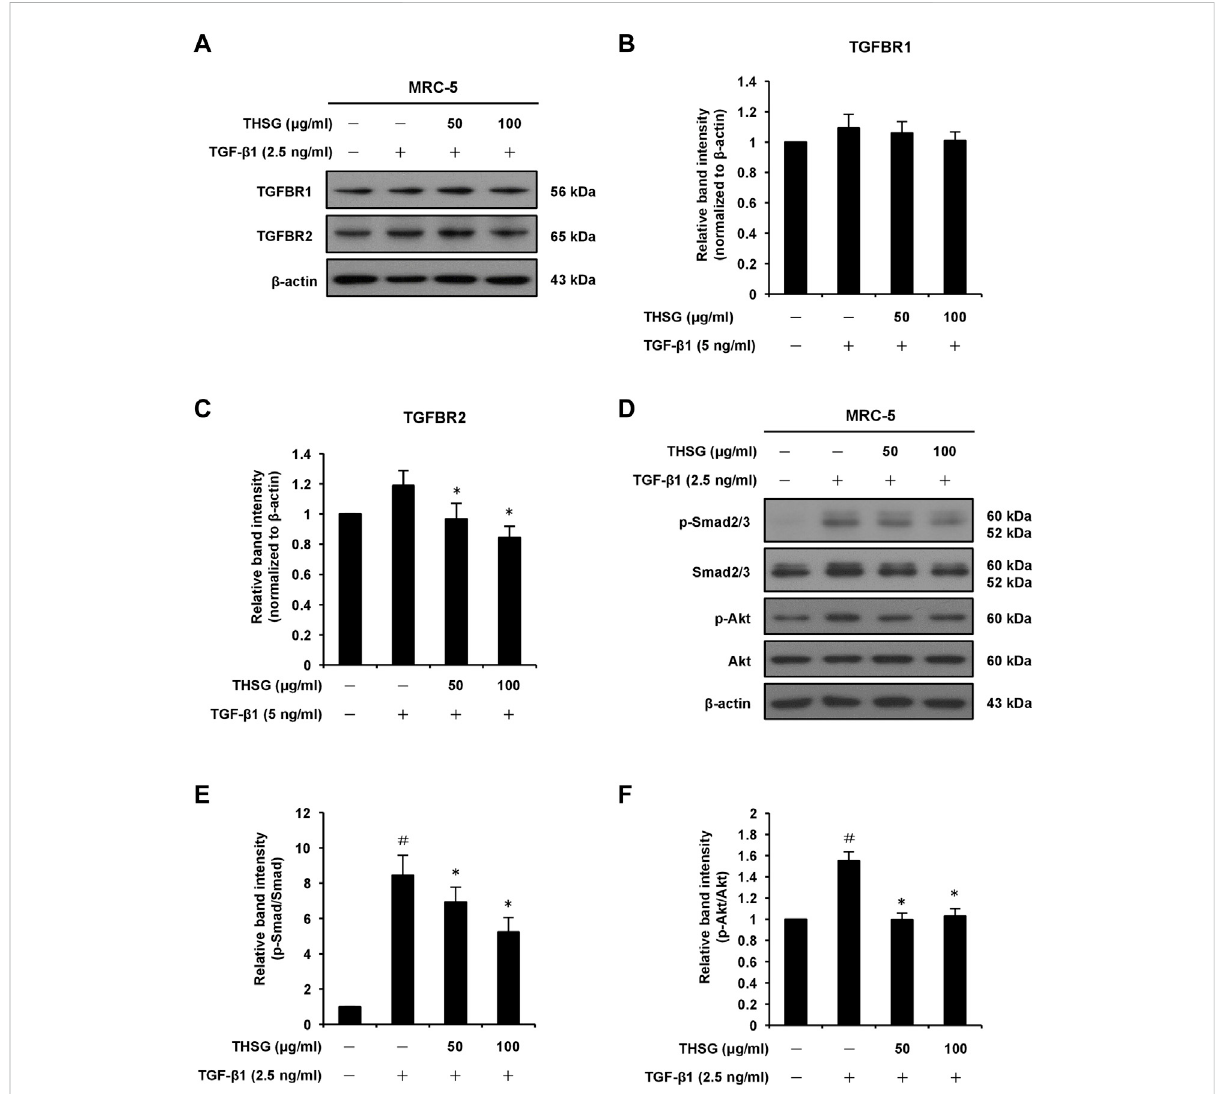
FIGURE 3 Effect of THSG on TGF- β receptors and TGF- β 1-induced Smad-dependent and -independent signaling pathways in MRC-5 human lung fi broblast cells. Con fl uent cultures of cells were serum starved for 24 h, before treatment with the indicated concentrations (50 and 100 μ g/ml) of THSG for 24 h, and then stimulated with 2.5 ng/ml of TGF- β 1 for 1 h (for TGFBR1 and TGFBR2), 6 h (for Smad2/3, Akt, ERK1/2, p38, and JNK), or 24 h (formTOR).Wholecelllysateswerepreparedattheindictedtimes,andanalyzedbyWesternblotting.The β -actinwasusedasaloadingcontrol. (A) RepresentativeblotsofTGFBR1andTGFBR2areshown.Therelativeproteinlevelsof (B) TGFBR1and (C) TGFBR2werequanti fi edbydensitometry andnormalizedto β -actin. (D) Representative blots ofp-Smad2/3,Smad2/3,p-Akt andAktare shown. Quanti fi cation of (E) p-Smad2/3and (F) p-Akt proteins was achieved by densitometry with reference to the respective Smad2/3 and Akt proteins. (G) Representative blots of p-mTOR and mTOR are shown. (H) Quanti fi cation of p-mTOR protein was achieved by densitometry and normalized to mTOR protein. (I) Representative blots of p-ERK1/2, ERK1/2, p-p38, p38, p-JNK, and JNK are shown. Quanti fi cation of (J) p-ERK1/2, (K) p-p38, and (L) p-JNK proteins was achieved by densitometry with reference to the respective ERK1/2, p38, and JNK proteins. Data are represented as the mean ± SEM of three